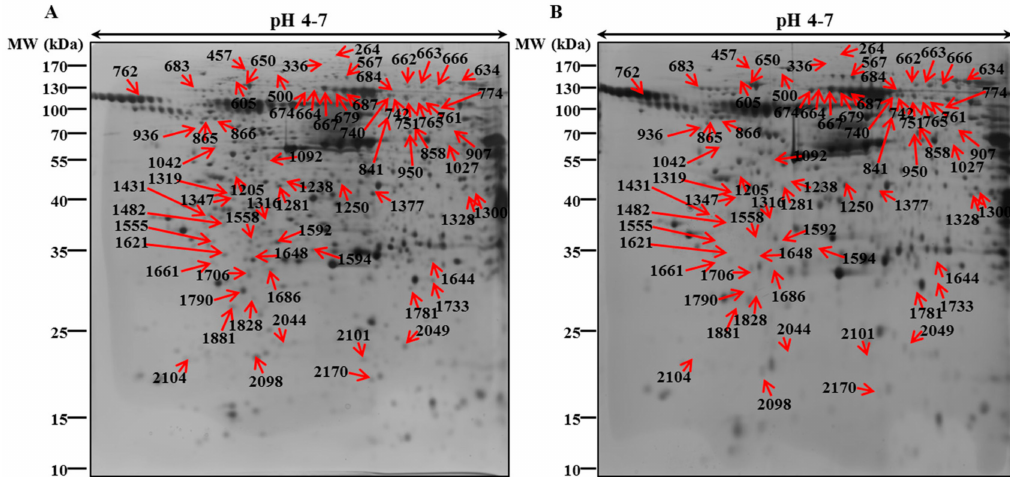
Figure 3. Representative Two-dimensional gel electrophoresis maps of the control and pectolinarigenin- treated MKN28 cells. The ( A ) control and ( B ) PEC-treated (100 µ M) of MKN28, the cells were incubated with the 100 µ M of PEC for 24 h. The total proteins were separated on 18 cm linear IPG strips (pH 4–7) in the first dimension and in the second dimension with 12% SDS-PAGE. The gels were then silver stained. The numbered arrows indicate protein spots successfully identified by matrix-assisted laser desorption/ionization time-of-flight mass spectrometry (MALDI/TOF-MS). The experiments were performed in triplicate.